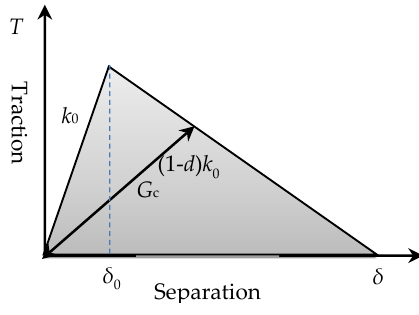
Figure 9. Cohesive Figure 9. Cohesive behavior.